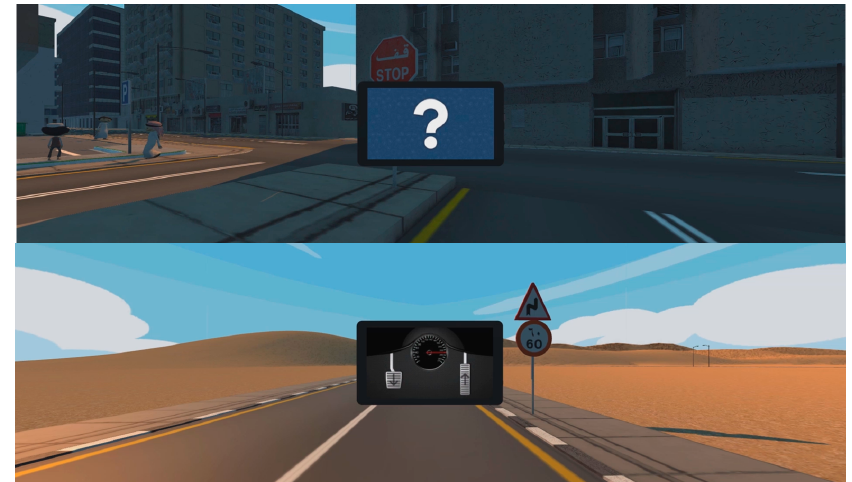
Figure 7. Examples of tablet pause, where a question is made and then users are requested to choose one option from a list of different answers ( top ); and users are requested to use the car’s controls ( bottom